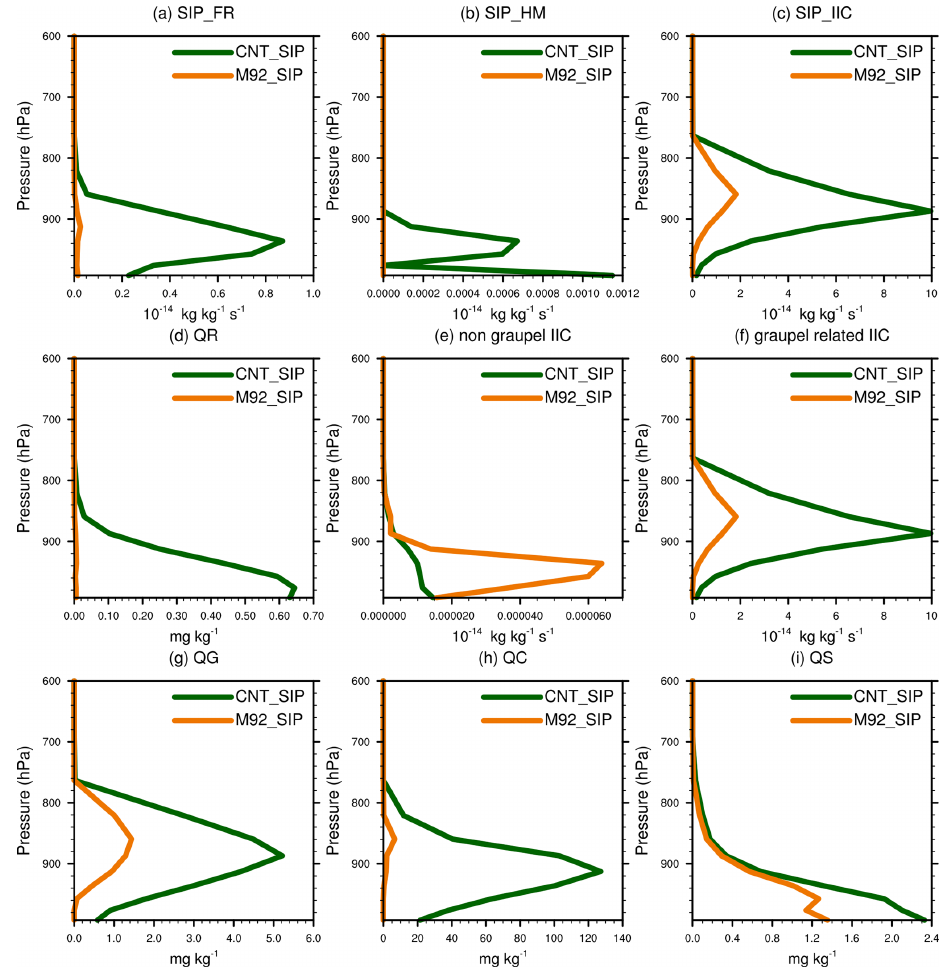
Figure 10. Vertical profiles of (a) rain droplet shattering rate during freezing (FR), (b) rime splintering rate (HM), (c) ice-ice collision fragmentation rate (IIC), (d) rain water mixing ratio ( q r , in unit of mgkg − 1 ), (e) non-graupel-related ice-ice collision fragmentation rate, (f) graupel-related ice-ice collision fragmentation rate, (g) graupel mass mixing ratio ( q g , in unit of mgkg − 1 ), (h) cloud water mass mixing ratio ( q c , in unit of mgkg − 1 ), and (i) snow mass mixing ratio ( q s , in unit of mgkg − 1 ) from the CNT_SIP and M92_SIP